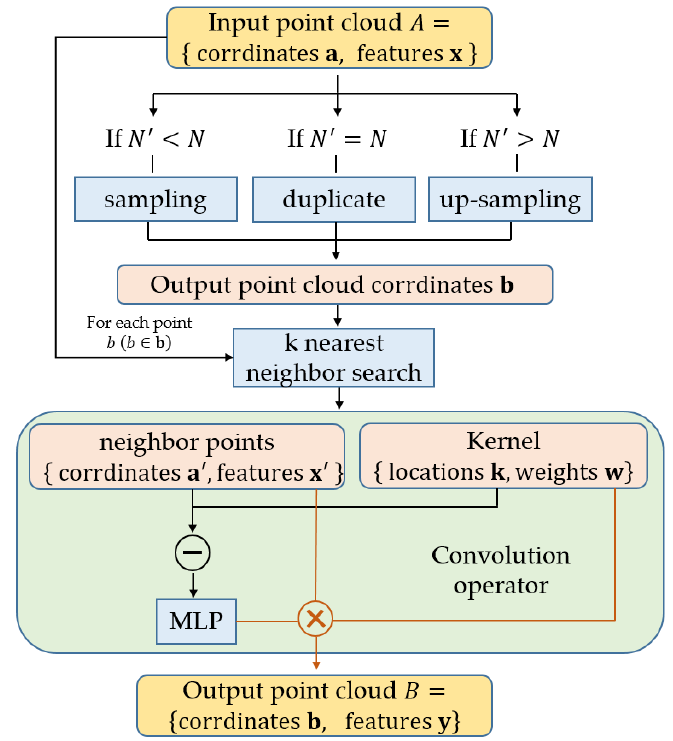
Figure 2. The process of the convolution layer.